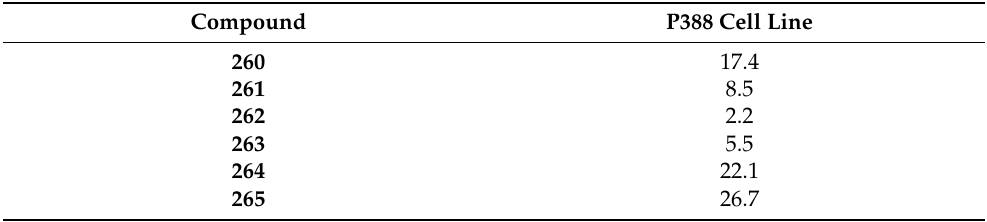
Table 3. Cytotoxity of anthcolorin compounds (IC 50 , µ M). Reproduced with permission [132]. Copy- right 2013,